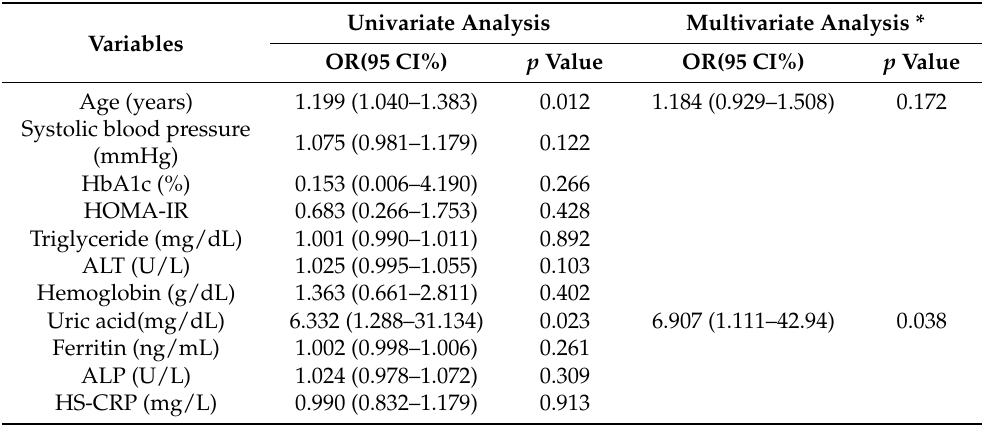
Table 3. Univariate and multivariate analysis of variables associated with risk of advanced liver fibrosis with FIB-4 > 2.67.